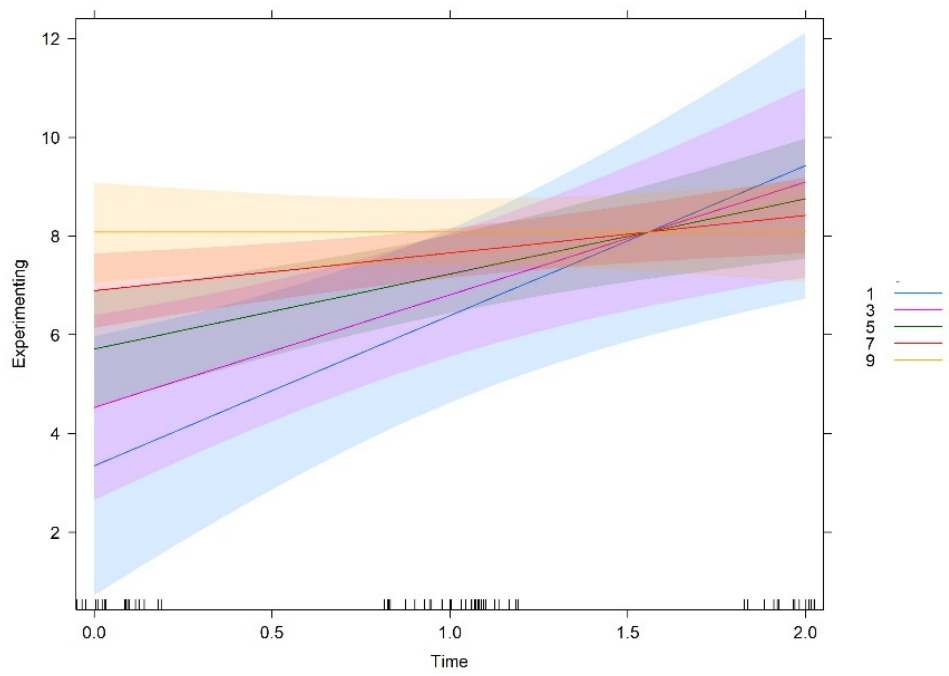
Figure 2. Interaction effect between time and innovation.